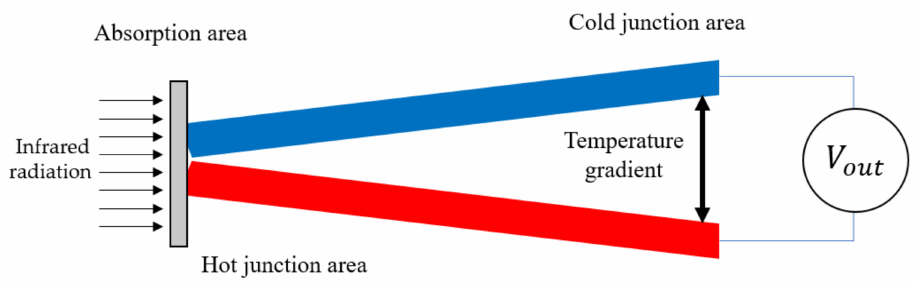
Figure 8. Schematic diagram of Seebeck effect